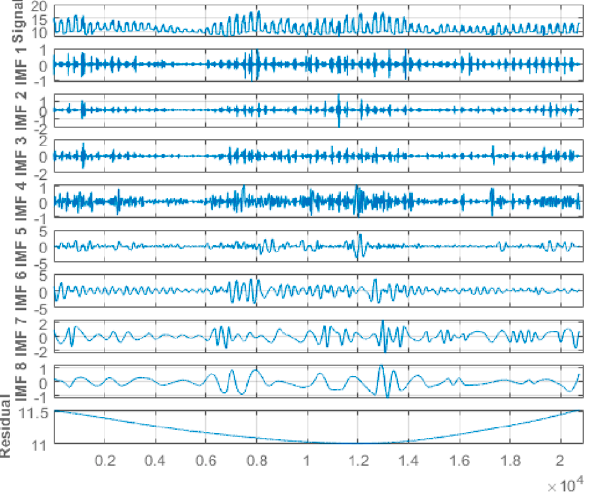
Figure 7. Eight (8) different IMFs and the corresponding residual for dissolved oxygen data signal.